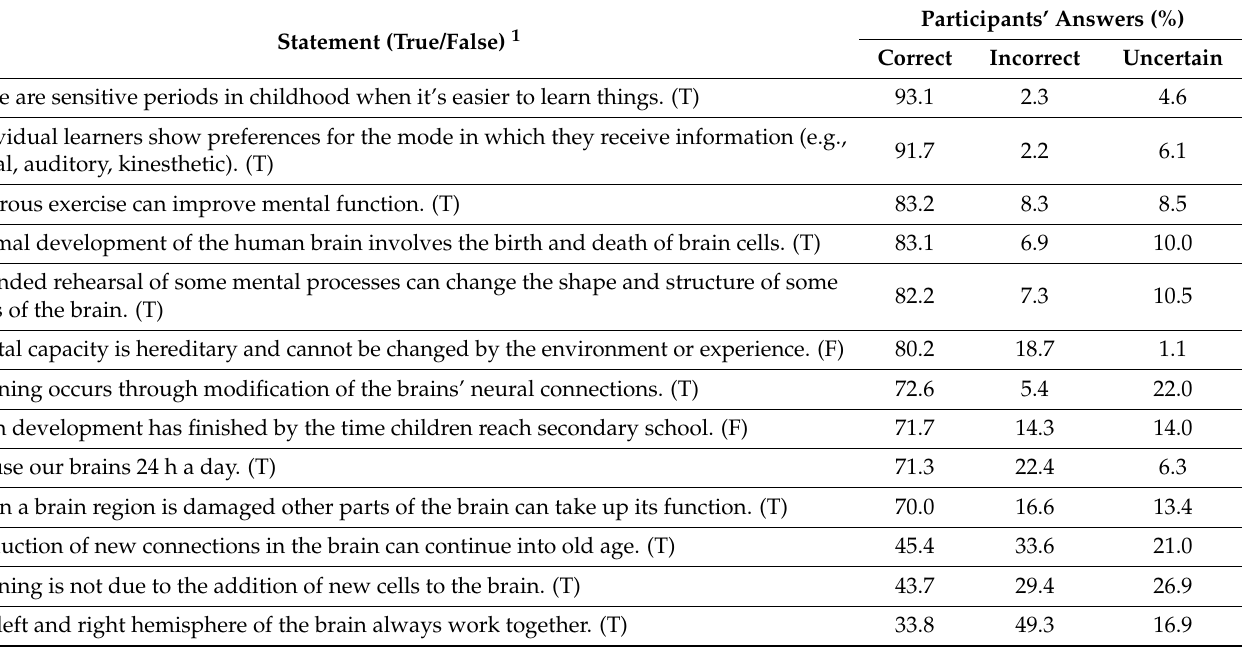
Table 5. Participants’ answers to statements related to general knowledge about the brain (in descending order of the rate of correct